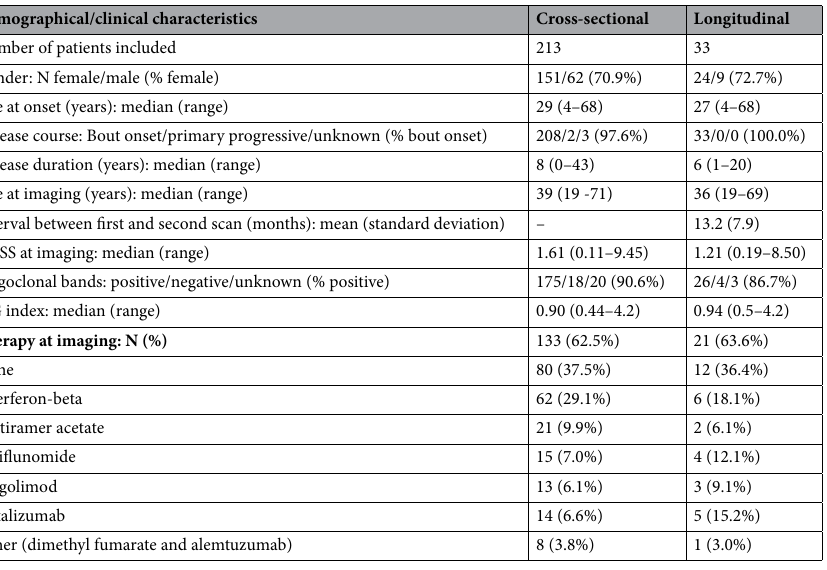
Table 1. Demographics of the study